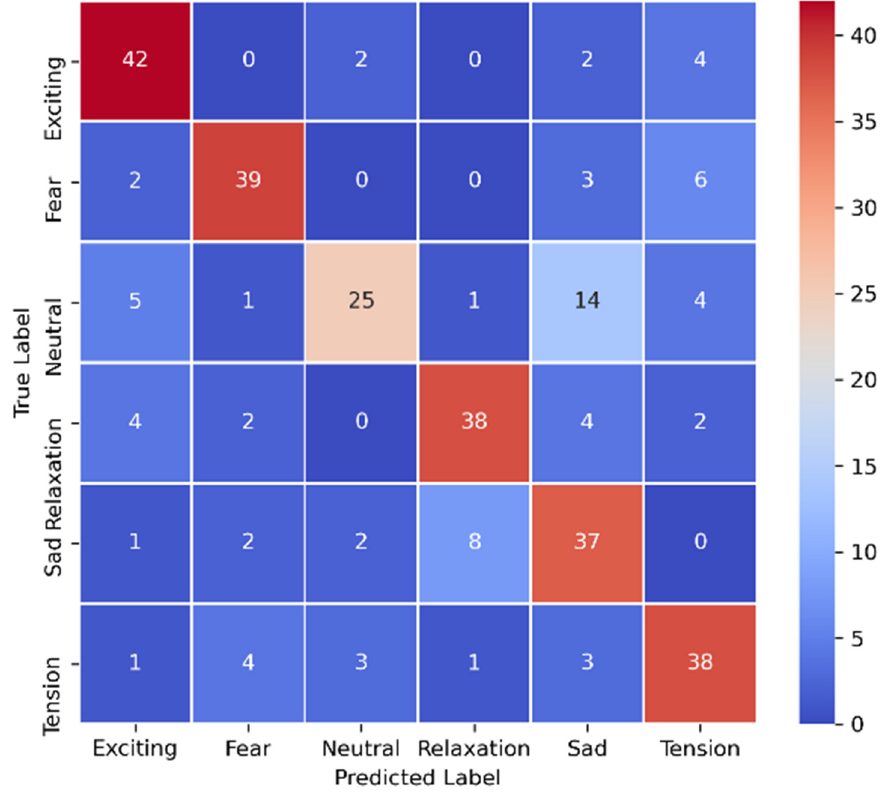
Figure 5. The confusion matrix using our best-performing multimodal architecture.